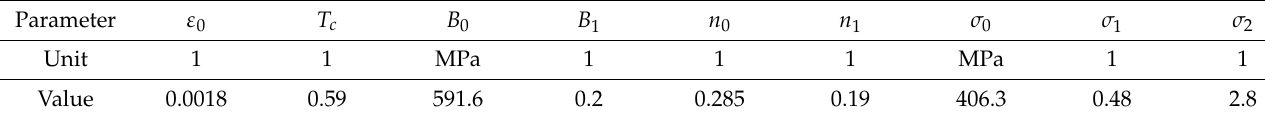
Table 6. Parameters of the RK model for mild steel ES ( 𝜀(cid:4662) (cid:2896)(cid:2886) = 10 − 6 s − 1 , 𝜀(cid:4662) (cid:2905)(cid:2886) = 10 6 s − 1 , and T m = 1793 K) [16].